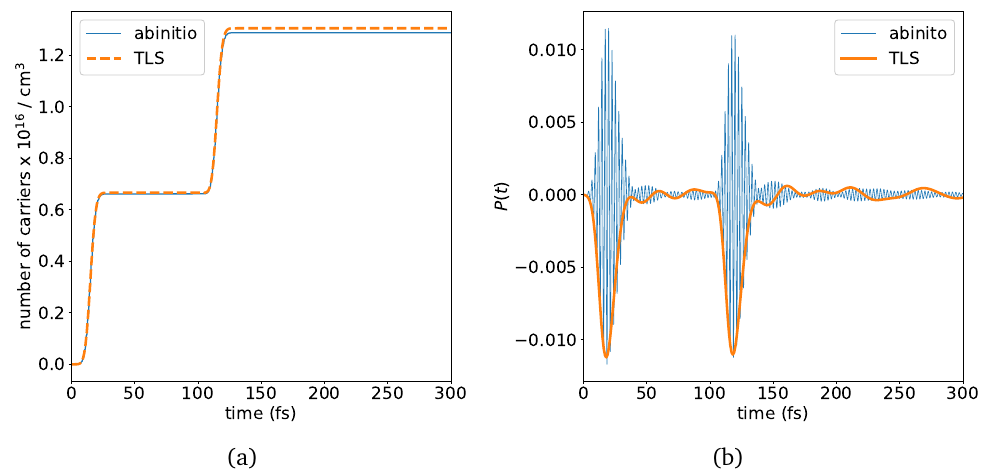
Figure 3: (a) Time dynamics of the carriers in the low-field regime. The blue (con- tinuous) line shows the ab initio real-time simulation and the orange dotted line is result of the TLS modelization of the system. (b) Time dynamics of the polarization in the low-field regime. The blue and orange curves show the ab initio real-time and the TLS results, respectively. Note that TLS results are computed in the rotating frame , so the oscillations of frequency ω are 0